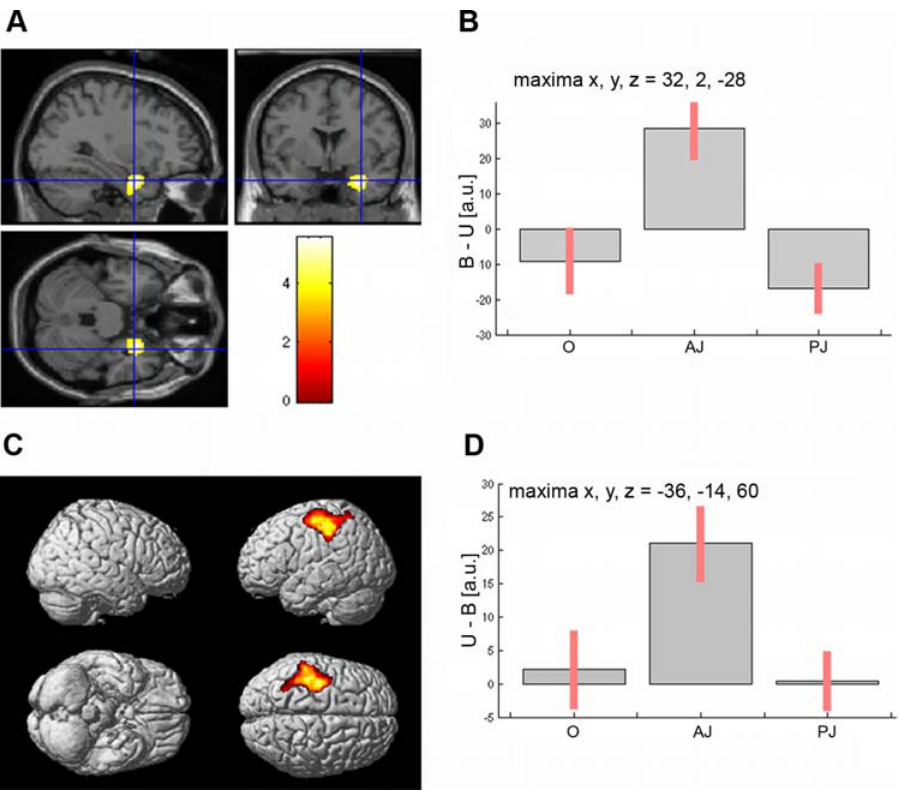
Figure 4. Brain activations in the contrasts ‘‘judged-as-beautiful vs. judged-as-ugly’’ and ‘‘judged-as-ugly vs. judged-as-beautiful’’ stimuli. a , Parasagittal, coronal and transaxial sections showing activation of the right amygdala in the interaction stimulus (beautiful vs . ugly) 6 condition (observation; aesthetic judgment; proportion judgment). b , Activity profile of the right amygdala. For each condition (O=observation, AJ=aesthetic judgment, PJ=proportion judgment) the signal plots show the difference between beautiful (B) minus ugly (U)-as judged sculptures in arbitrary units (a.u), + / 2 10% confidence intervals. c , Statistical parametric maps rendered onto the MNI brain template showing activity within left somatomotor cortex in the contrast of ugly vs. beautiful stimuli averaged across the three conditions. d , Activity profile (ugly-beautiful) of the left motor cortex. For each condition (O, AJ, PJ) the signal plots show the difference between ugly (U) minus beautiful (B)-as judged sculptures in arbitrary units (a.u), + / 2 10% confidence intervals ( P -corrected ,